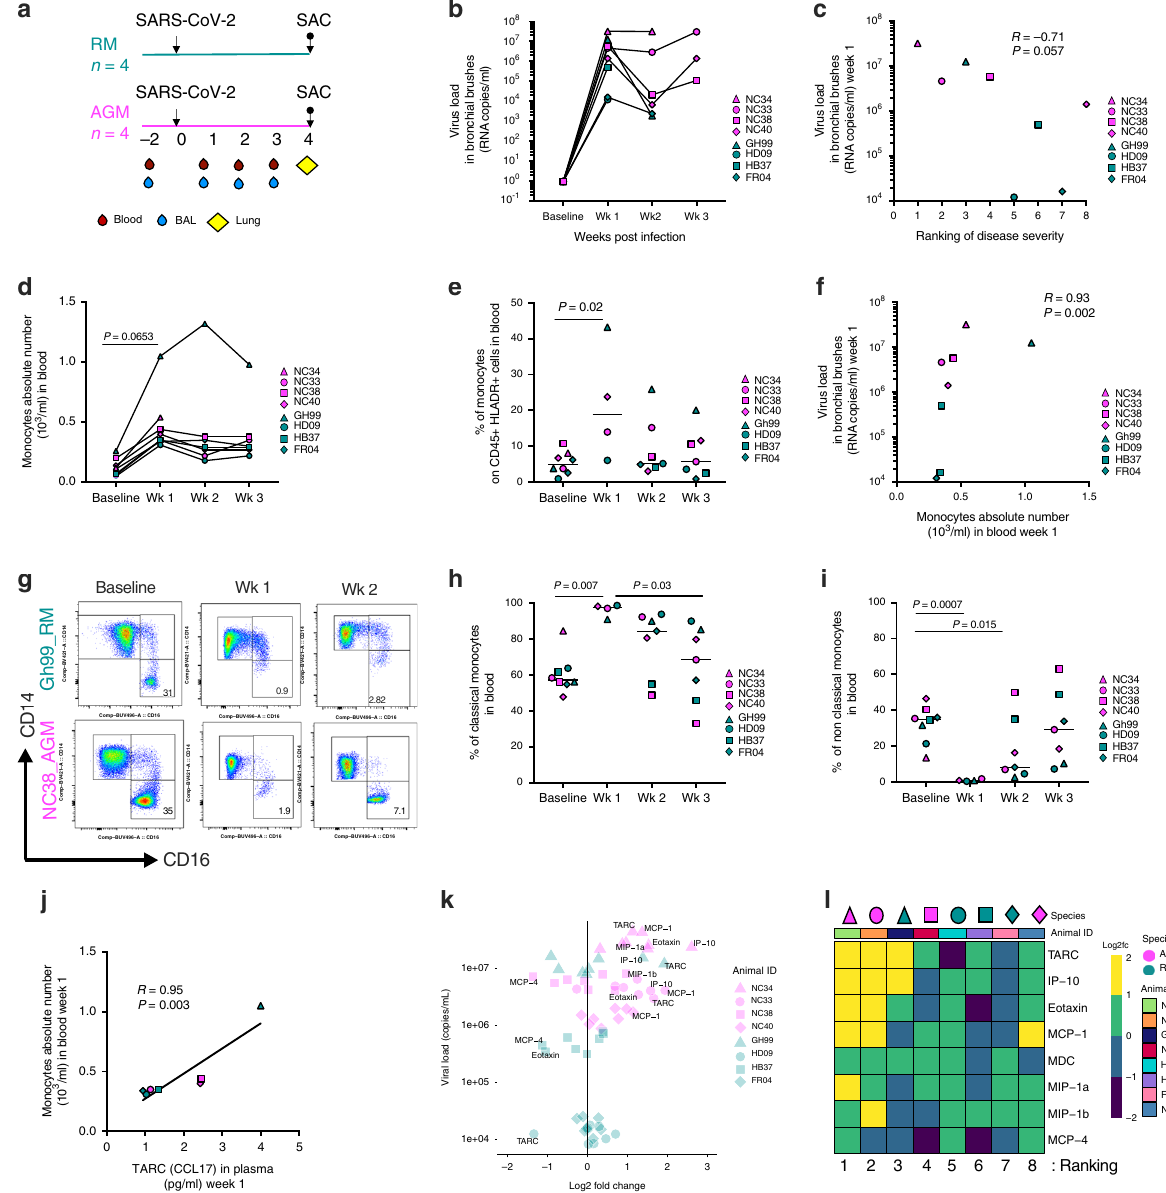
Fig. 1 Monocytes are a correlate of bronchoalveolar viral replication. a Schematic of study design. Arrows represent time of inoculation with SARS-CoV-2 (day 0) or sacri fi ce (up to 28 days post-infection). Unless stated otherwise, rhesus macaque data are shown in teal, and African green monkey data are shown in magenta. b SARS-CoV-2 RNA levels in bronchial brushes over time. c Association between SARS-CoV-2 load in bronchial brushes and ranking of disease severity in all eight animals (most severe case = 1; mildest case = 8) (Spearman test, n = 8). d Changes in monocyte count in blood before and after infection (by one-way ANOVA adjusted, for multiple comparisons by Tukey ’ s test, n = 8). e Proportion of total monocytes (HLA-DR + CD16 + and/or CD14 + out of CD45 + leukocytes) in PBMCs over time (baseline and week 1 = 8 animals, week 2, 3 = 7 animals, Kruskal – Wallis test, Dunn ’ s multiple comparisons). f Correlation between SARS-CoV-2 viral load in bronchial brushes and absolute count of monocytes in blood at 1-week post-infection (1wk pi) ( n = 8). g Representative fl ow cytometry changes in non-classical monocytes (CD14 low CD16 hi ) after the infection in the blood (1wk pi). h Percent of classical (CD14 hi CD16 low ) and i non-classical monocytes (CD14 low CD16 hi ) out of total monocytes in PBMCs (baseline = 8 animals, week 1 = 4 animals, week 2, 3 = 7 animals; Kruskal – Wallis test, Dunn ’ s multiple comparisons). j Correlation between monocytes absolute numbers in blood and TARC (CCL17) in plasma (1wk pi). k Relationship between fold-change of chemokines and SARS-CoV-2 viral load in bronchoalveolar brushes (1wk pi). l Heatmap displaying log2 fold-change of eight chemokines involved with traf fi c of monocytes to the lung (1wk pi). Animals are ordered by ranking of disease severity. All correlations analyses are by the Spearman correlation